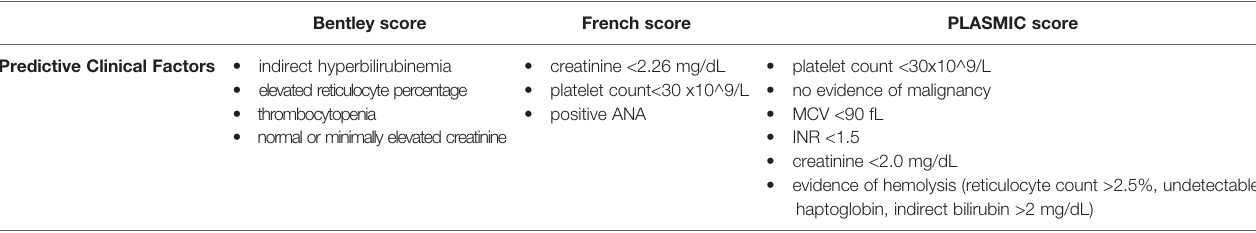
TABLE 1 | Clinical Scoring Systems for the Prediction of Severe ADAMTS13 De fi ciency (or TTP). Bentley